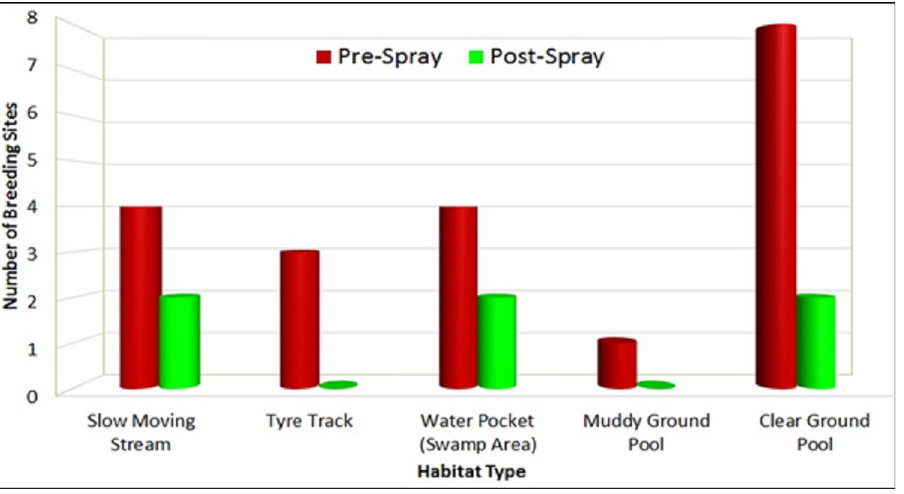
Fig 10. Distribution of breeding habitats of An . balabacensis